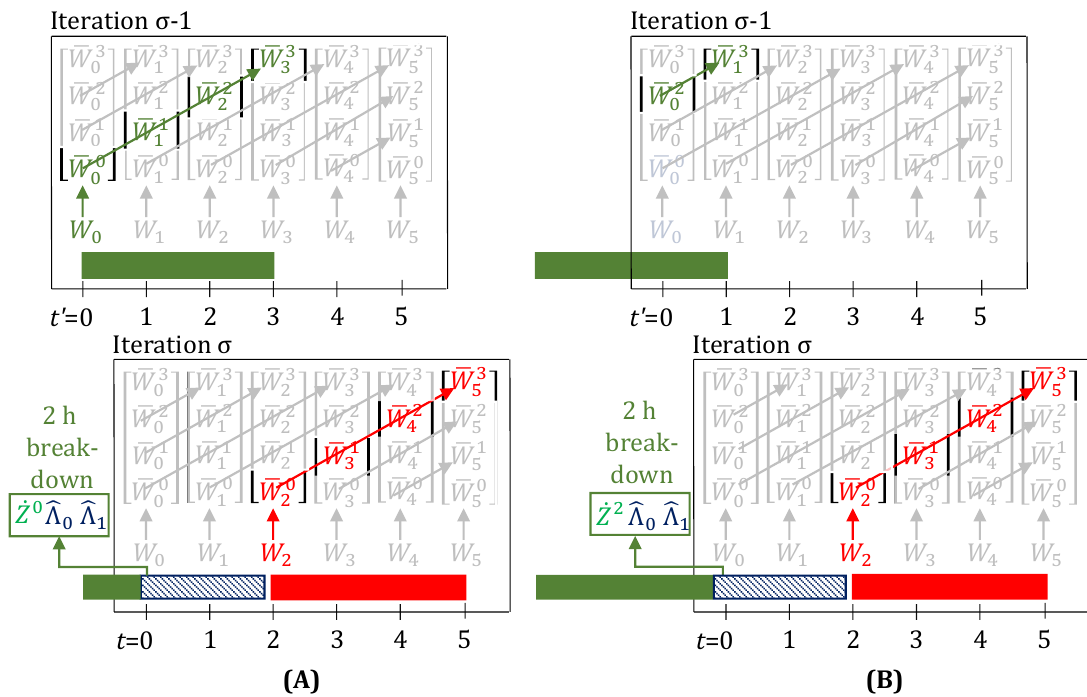
Figure 6. When a breakdown is observed, further evolution of the task-states for the task (the green trajectory), running on the unit that broke, stops. Here, τ for the task is 3 and the unit downtime (blue) is 2 h. Arrows show which variables are enforced as equal by the lifting equations (Equations (22)–(24)). Variables and parameters in green, blue, or red have a value of 1, rest have value 0. The green task is suspended at t = 0. A new task (red) can only start at t = 2, once the unit downtime is over. Through Equation (25), the unit is kept busy at t = 0 and 1, by the inclusion of the terms ˆ Λ t = 0 and ˆ Λ t = 1 . ( A ) The parameter ˙ Z 0 , through Equation (20), prevents the task-state from evolving from ¯ W 0 . ( B ) The parameter ˙ Z 2 , through Equation (20), prevents the task-state from evolving to σ ¯ W 1 ( σ − 1 ) 0 0 ¯ W 2 from to σ ¯ W 3 ( σ − 1 ) 0 0